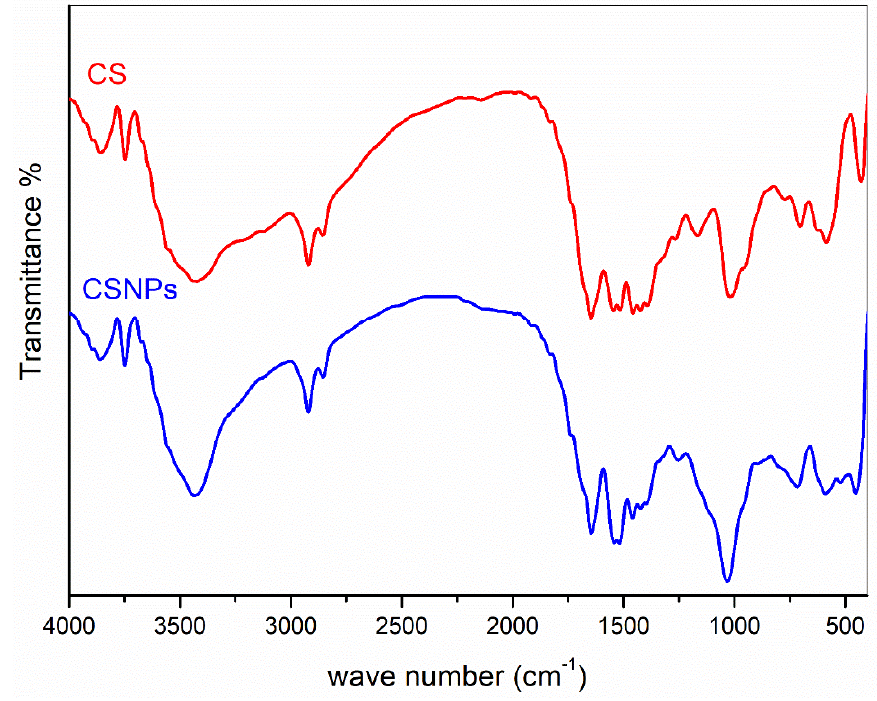
Figure 4. FT-IR spectra of chitosan and prepared chitosan nanoparticles.